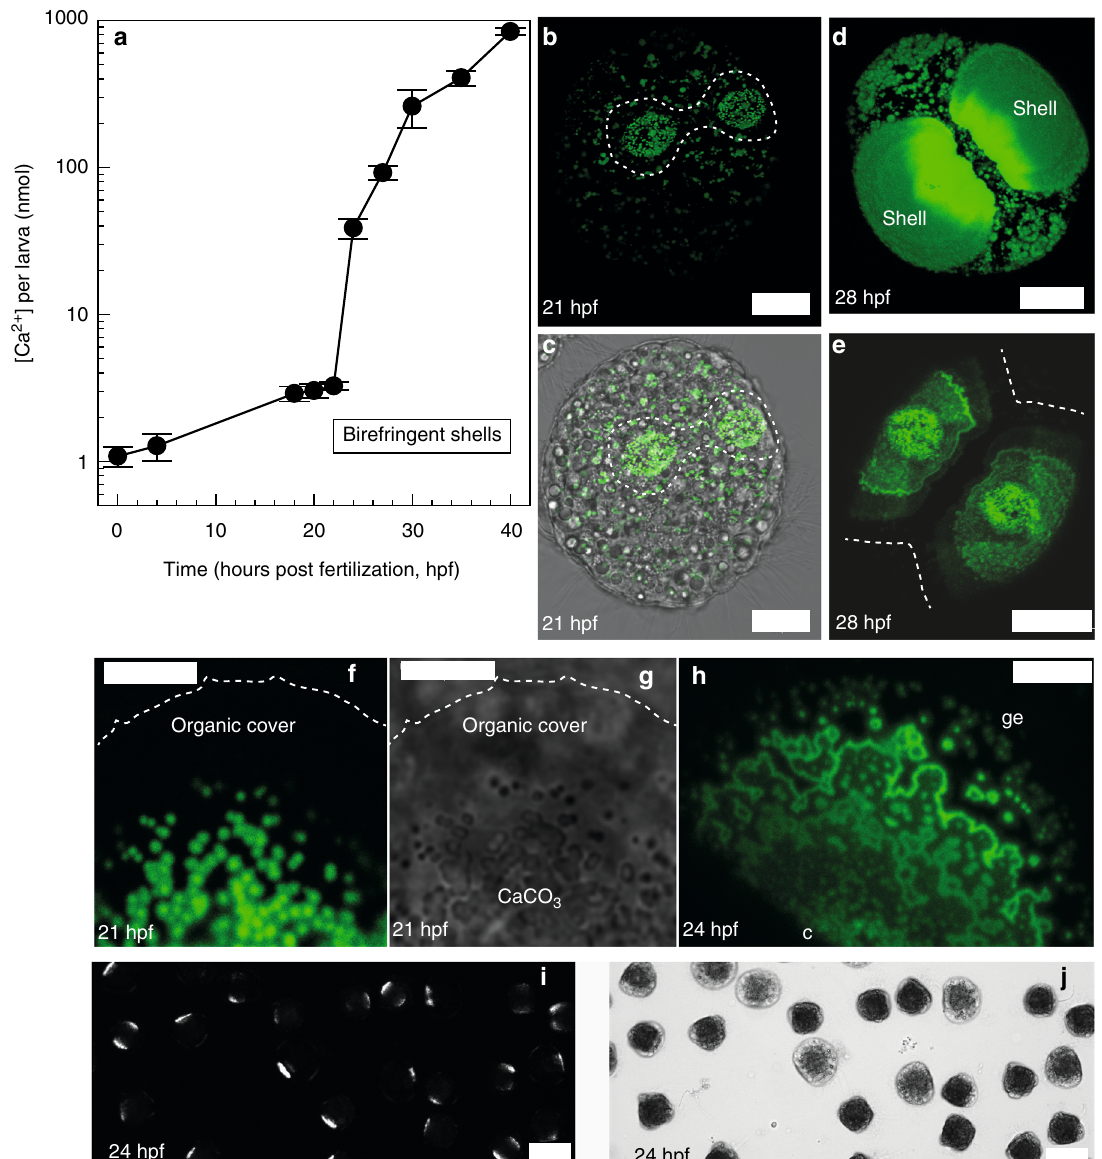
Fig. 1 Calcium accumulation and in vivo larval shell formation from Exp 1 and 2. a larval calcium accumulation during the fi rst 48hpf, N = 4 fertilizations, means and s.d. Shells are birefringent from 21hpf onwards. b Confocal projection of early stage of shell formation in 21hpf trochophore larva, calcein positive particles are deposited onto tissue facing side of organic shell cover and numerous calcein positive intracellular vesicles are visible underneath. Shell organic cover boundaries indicated by dashed line. c Same larva, merged transmission and calcein fl uorescence images. d confocal projection of 28hpf larva viewed from the hinge, which is not calci fi ed yet. Shell fl uorescence overexposed to visualize intracellular calcein positive vesicles. e Same larva imaged at lower intensity to illustrate shell details, calcein positive particles visible in the centre of each valve, dotted line indicates boundaries of the organic shell cover. f Close-up of calcein positive deposits attached to the organic shell cover in 21hpf larva, organic cover boundary indicated by dotted line. g Same larva, transmission image. h Confocal projection of shell material secreted by 24hpf larva, note deposits at the centre of the valve (c) and at the growing edge (ge). i Larvae in vivo under crossed polarized light, see also Supplementary Movie 1 for swimming and rotating larvae. j Same larvae, transmitted light. Scale bars: 20 µ m b – e , 5 µ m f – h , 75 µ m i ,